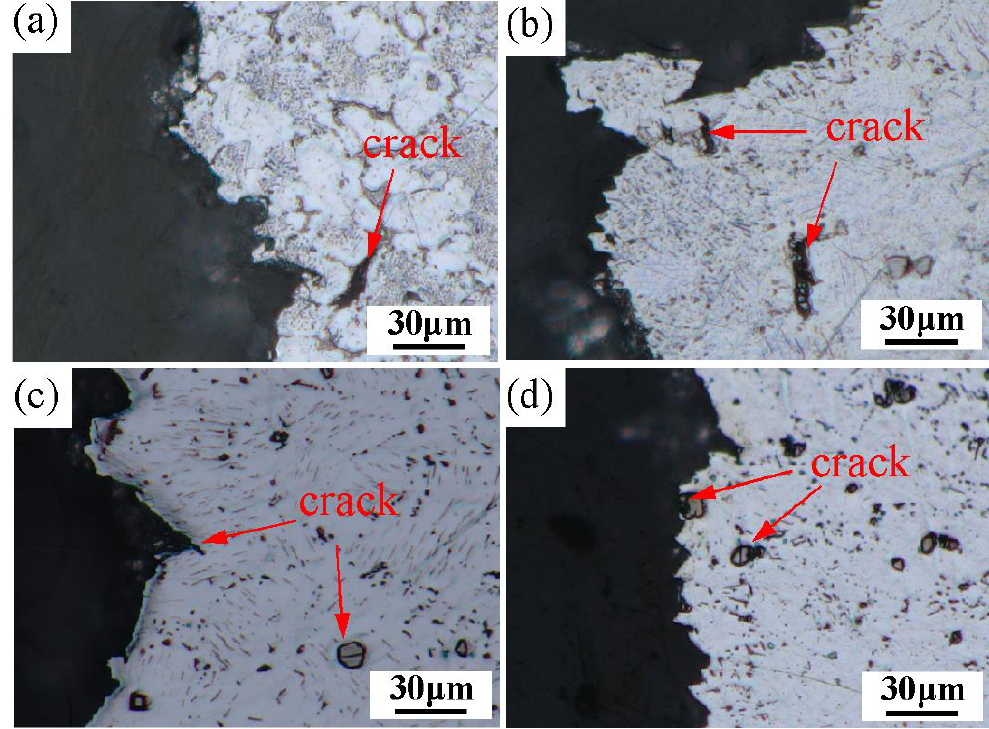
Figure 12. Metallography of side fracture of the Mg-3Y-4Nd-2Al alloy after solution treatment for different time periods:( a ) 0 h; ( b ) 2 h; ( c ) 16 h; ( d ) 48 h